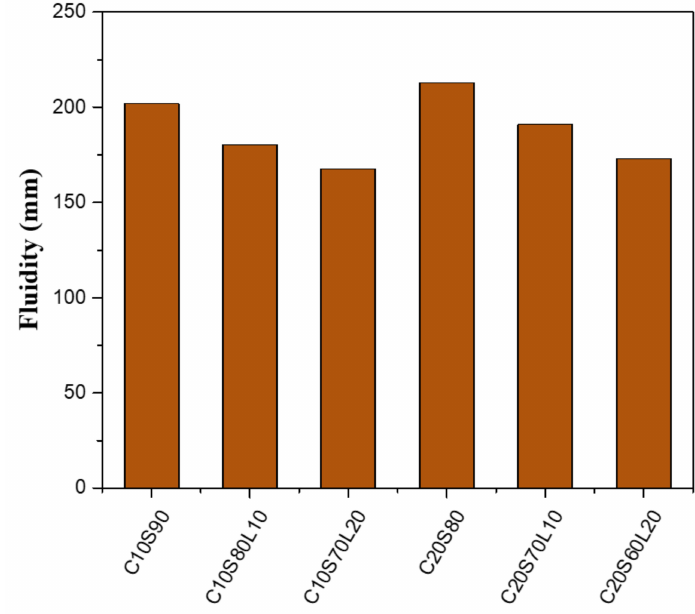
Figure 3. Fluidity of alkali-activated slag